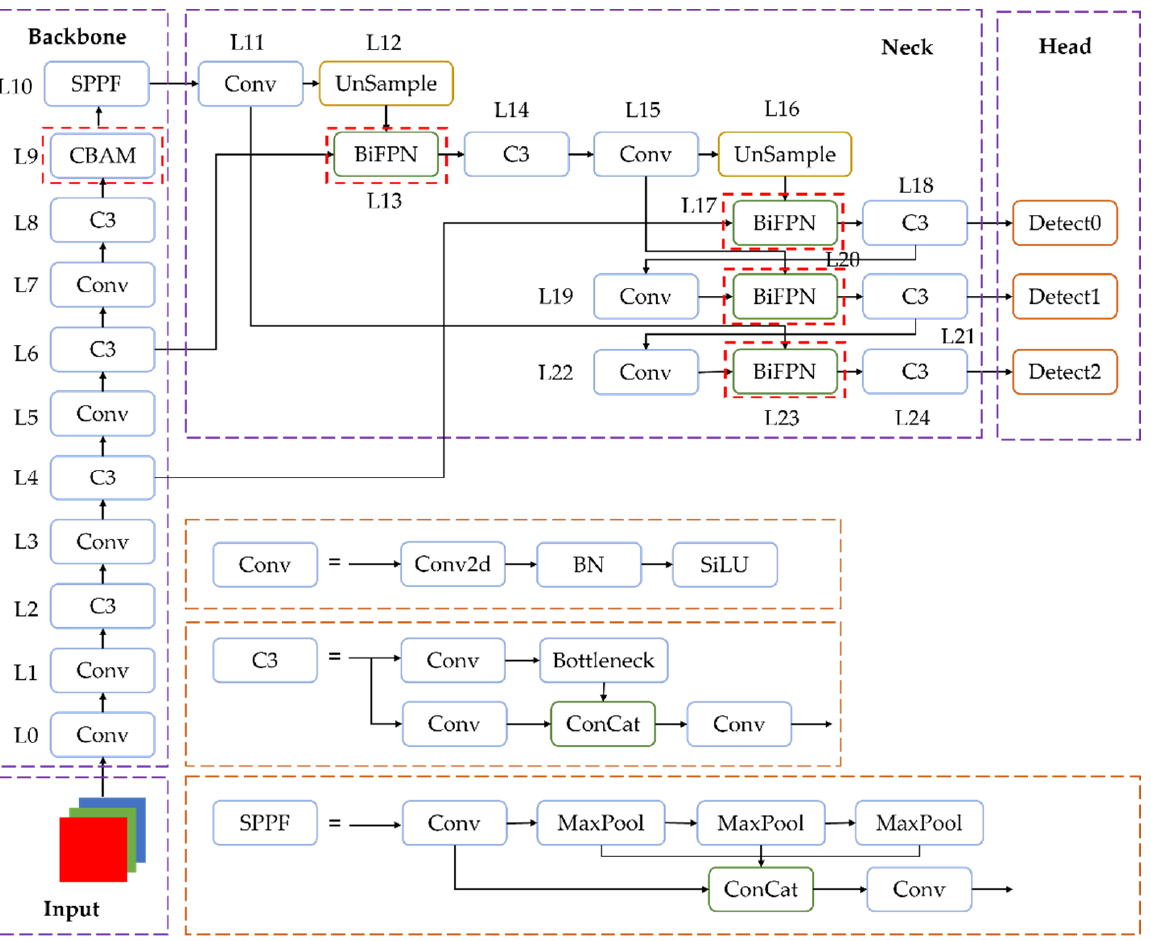
Figure 10. Improved Forest Fire Classification and Detection Model FCDM.